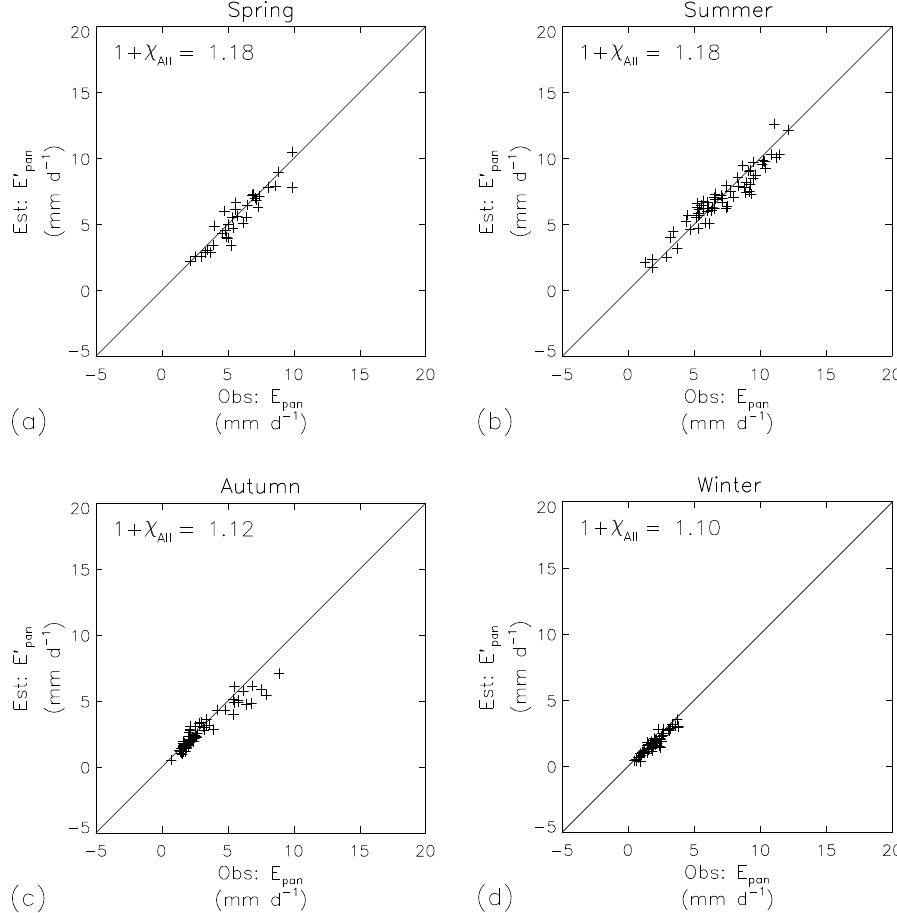
Fig. 11. Estimated E 0 pan versus observed E pan using a constant total correction factor (1 + χ All ) calculated separately (using 15 days) for each season. (1:1 line shown.) (a) Spring ( y =0.95 x + 0.09, R 2 =0.87, n =36, RMSE=0.75mmd − 1 ). (b) Summer ( y =0.84 x + 1.06, R 2 =0.90, n =64, RMSE=0.82mmd − 1 ). (c) Autumn ( y =0.78 x + 0.40, R 2 =0.91, n =68, RMSE=0.68mmd − 1 ). (d) Winter ( y =0.87 x + 0.02, R 2 =0.89, n =69, RMSE=0.35mmd − 1